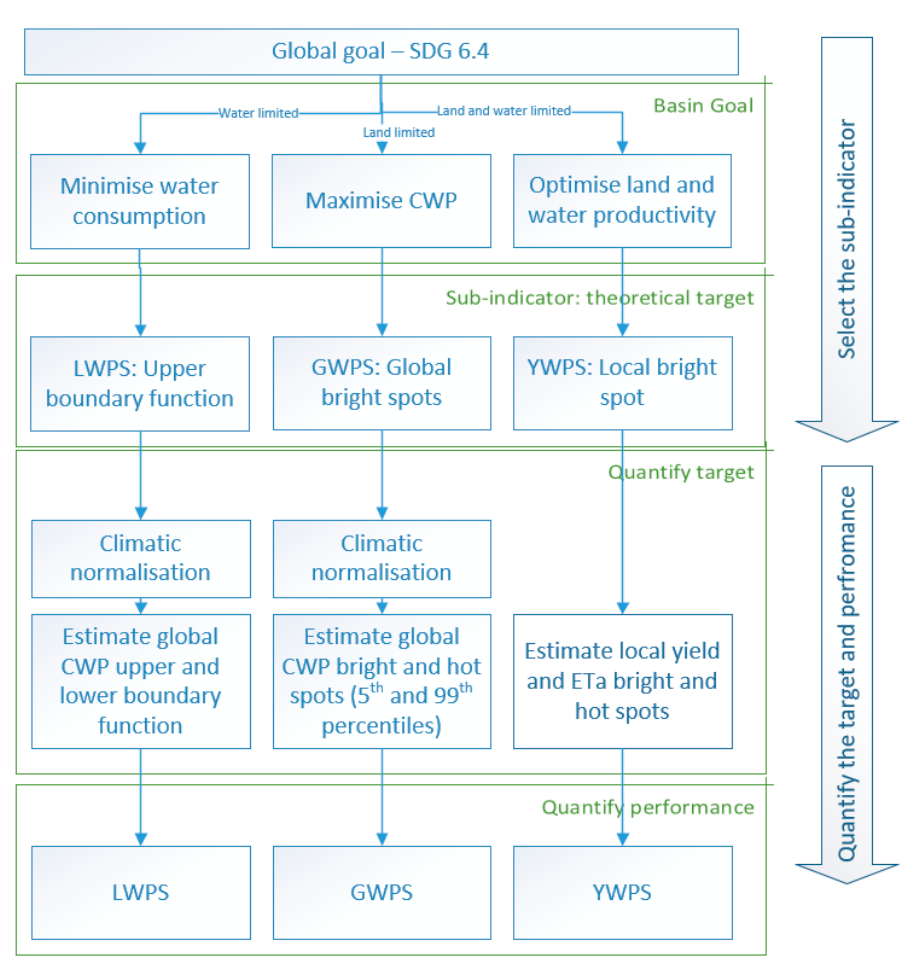
Figure 2. A CWP framework to guide the selection and estimation of CWP sub-indicators.